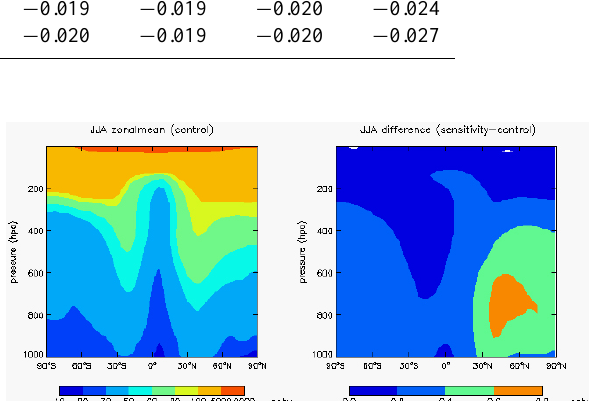
Fig. 2b. Same as Fig. 2a, but for